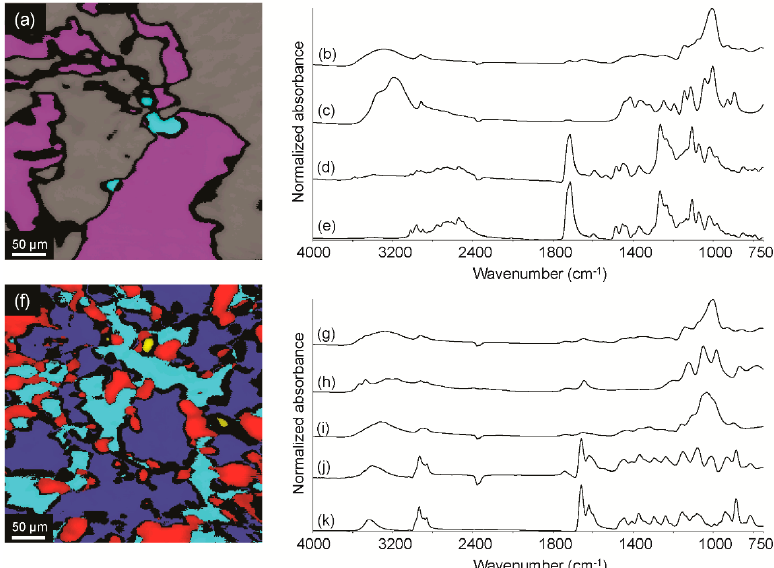
Figure 4. ATR-FT-IR image of Powder 1 ( a ); and representative spectra from the cyan ( b ); purple ( c ) and gray ( d ) regions compared to a pure compound reference spectrum of cocaine HCl ( e ); IR image of Powder 2 ( f ); and representative spectra from the cyan ( g ); red ( h ); blue ( i ) and yellow ( j ) regions compared to a pure compound reference spectrum of methandrostenolone ( k ).